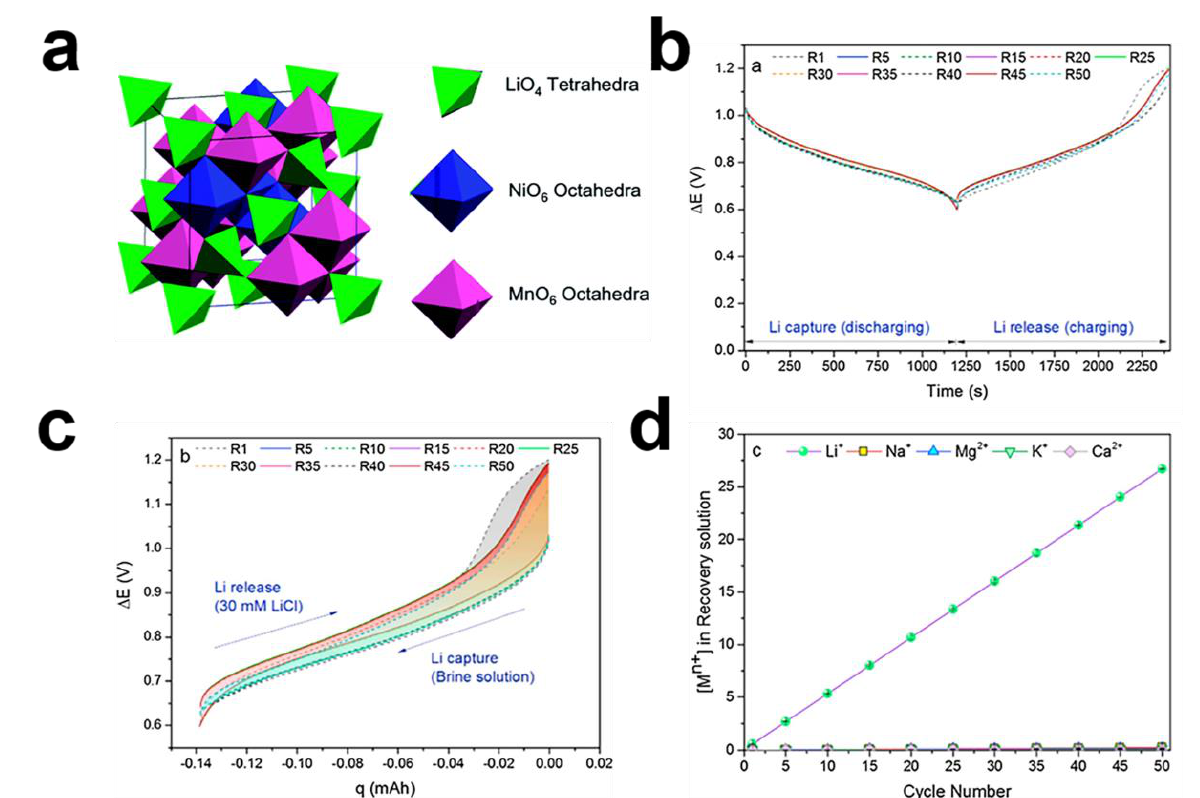
Figure 11. ( a ) Crystal structure of LiMn 1.5 Ni 0.5 O 4 . The cation ordering in the octahedral sites is indicated with different colors for MnO 6 and NiO 6 octahedra. Reprinted with permission from Ref. [67]. Copyright 2013 Royal Society of Chemistry. Recyclability test of NMO/Ag for Li + recovery (C-rate = 1.05 C and t = 20 min step − 1 ) performed for 50 cycles: ( b ) ∆ E time profiles of selected runs, ( c ) ∆ E vs. q plots for respective cycles and ( d ) Li + and competing Mn + concentrations in 30 mM LiCl receiving solution for respective cycles. Reprinted with permission from Ref. [69]. Copyright 2019 Elsevier. Table 1. Comparison of electrochemical Li recovery